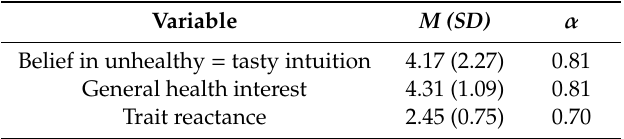
Table 2. Descriptive statistics and Cronbach’s alpha coe ffi cients of the measured scales.